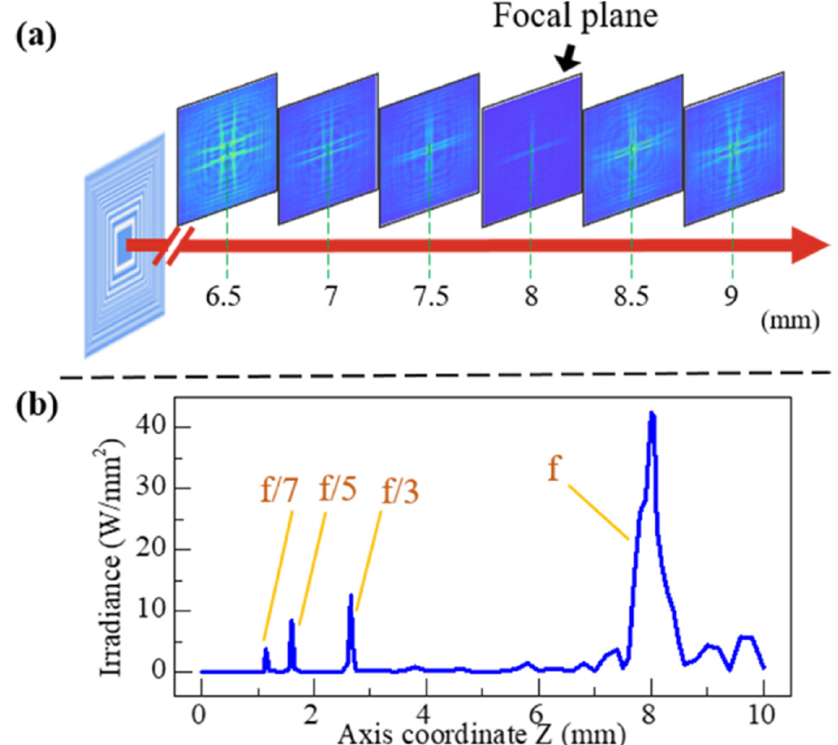
Figure 4. Simulation diagram of the energy distribution of S-FZP along the Z -axis: ( a ) the distribution of the cross-sectional energy; ( b ) energy profile along with the z -axis.